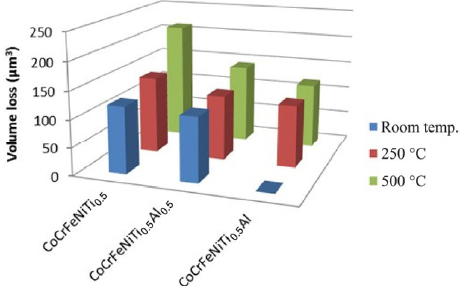
Fig. 4 Volume loss values of test samples at different sliding